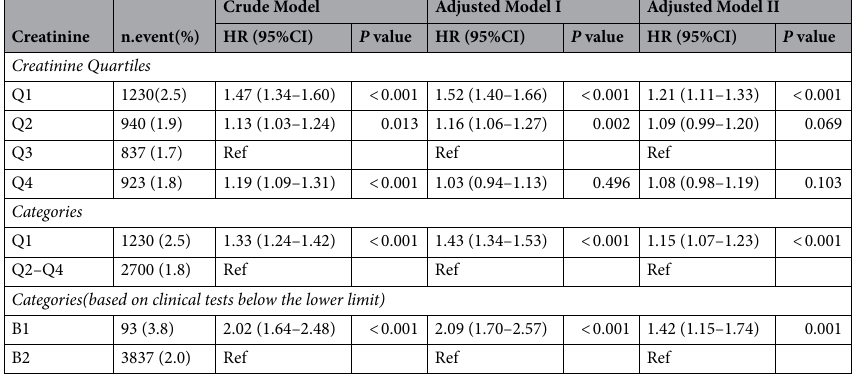
Table 2. Association between Creatinine and Type 2 Diabetes. Participants were divided by sex-specific quartiles (Q1–Q4) of serum creatinine level at baseline: < 71.8, 71.8 ≤ 79.0,79.0 ≤ 86.6 and 86.6–106.0 umol/L for men; < 51.6, 51.6 ≤ 57.0,57.0 ≤ 63.0 and 63.0–97.0 umol/L for women.Participants were divided by sex- specific quartiles (B1–B2)of serum creatinine level at baseline : < 57 and 57.0–106.0 umol/L for men; < 41.0